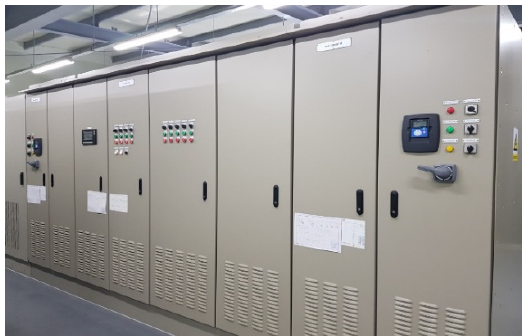
Figure 9. AC-DC hybrid distribution system of the testbed.